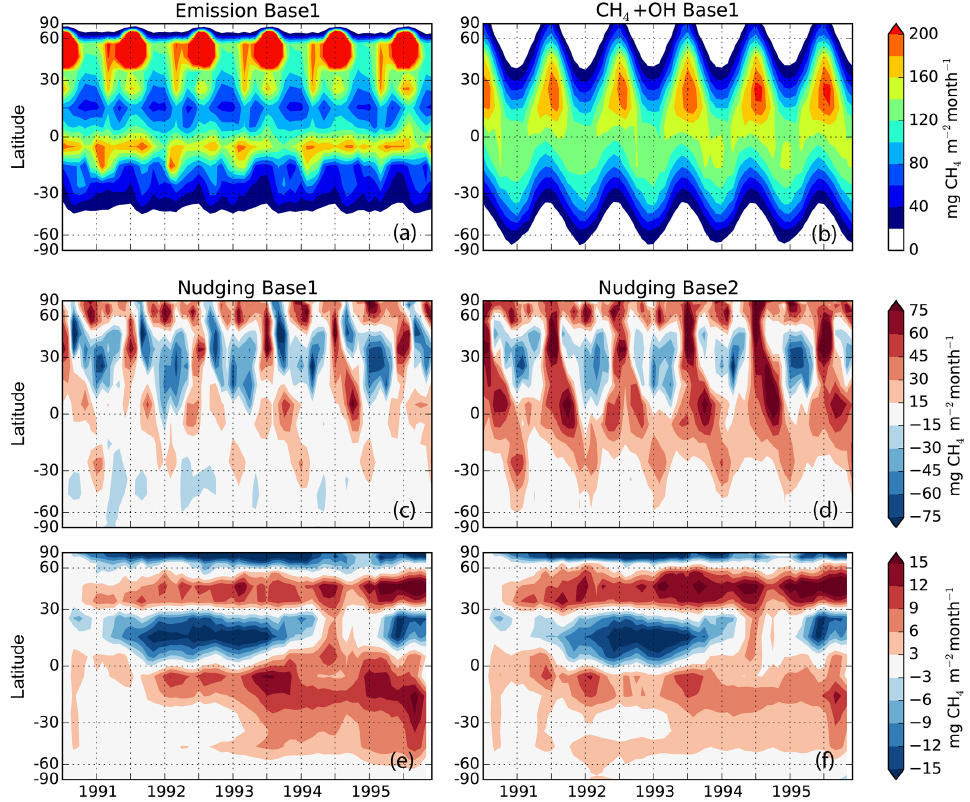
Figure 6. Zonal mean CH 4 (a) emission and (b) sink by reaction with OH in the Base1 simulation, zonal mean CH 4 nudging term when using CH 4 wetland emissions from (c) ORCHIDEE (Base1 simulation) and (d) LPJ (Base2 simulation), and (e) and (f) the deseasonalised nudging anomaly compared to